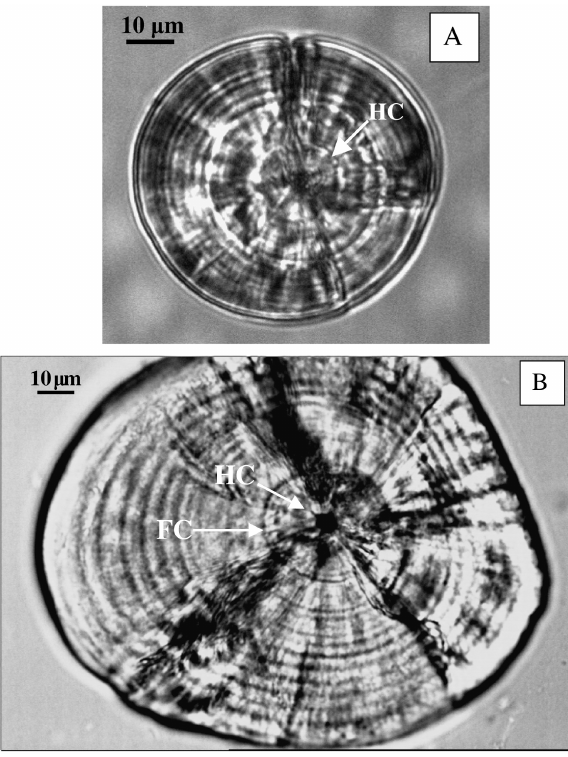
IG . 3. – Transmitted light pictures showing sagittal otoliths of European hake larvae: A) 4.2 mm SL and B) 6.0 mm SL. Hatch check (HC) and first feeding check (FC) are indicated by an